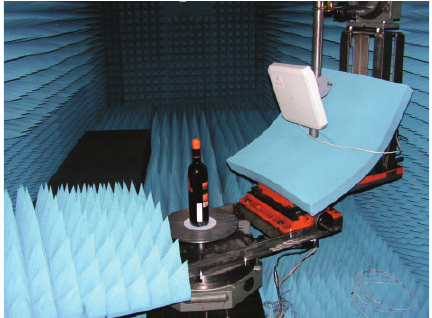
Figure3: Setup forthemeasurementsofreceived signal andreading arc around